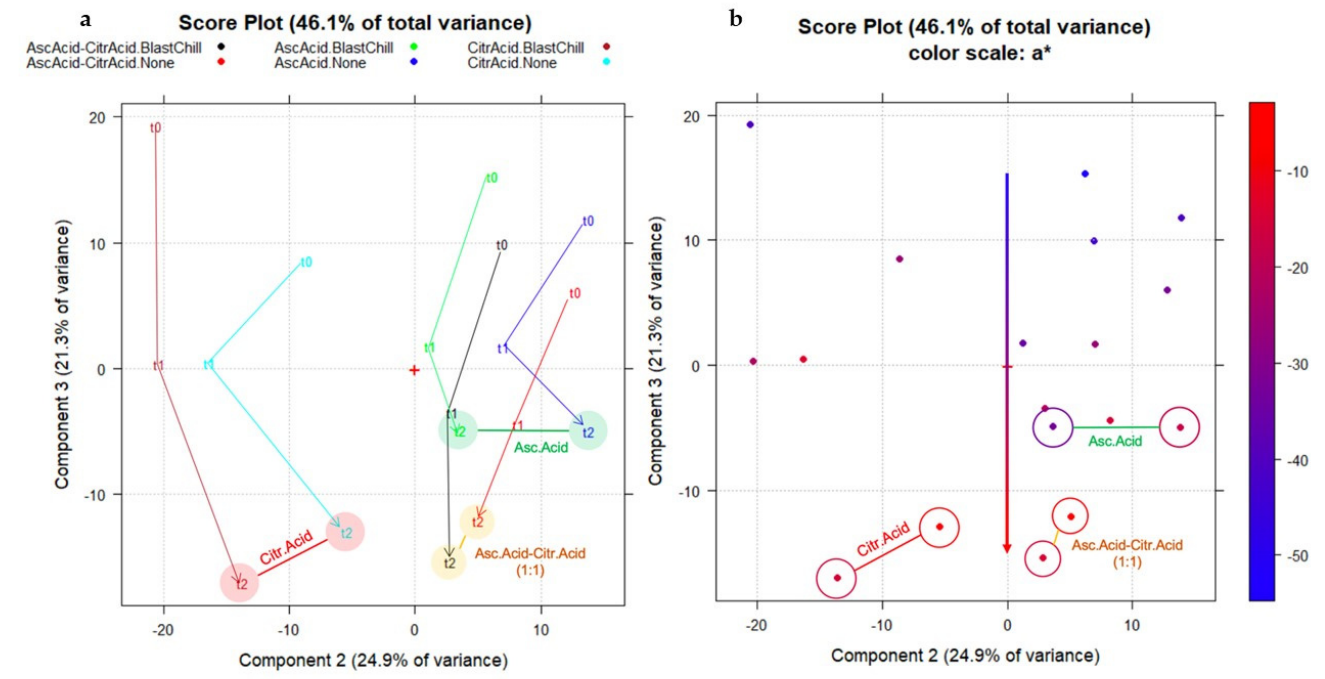
Figure 7. The score plot of data matrix B 18,521 in the plane PC2–PC3. ( a ) The objects were coded according to the time point (t0, t1, and t2), colored and line-connected according to the additive used in the formulation (ascorbic acid, citric acid or the mixture of ascorbic acid and citric acid); ( b ) the correlation between the a* coordinate (greenish–reddish) and PC3 scores was highlighted.